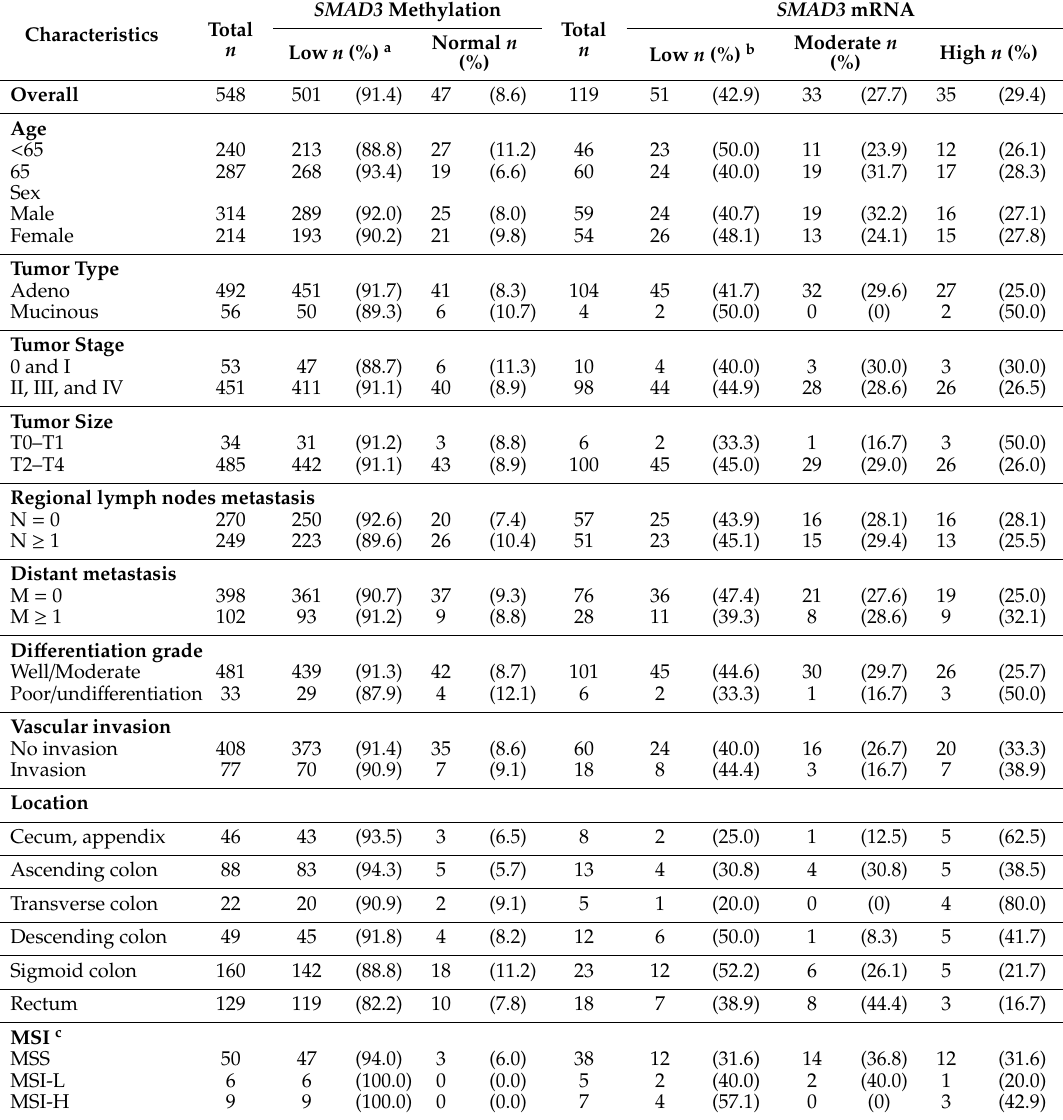
Table 1. Alterations of SMAD3 in relation to the clinical parameters of colorectal cancer (CRC) in